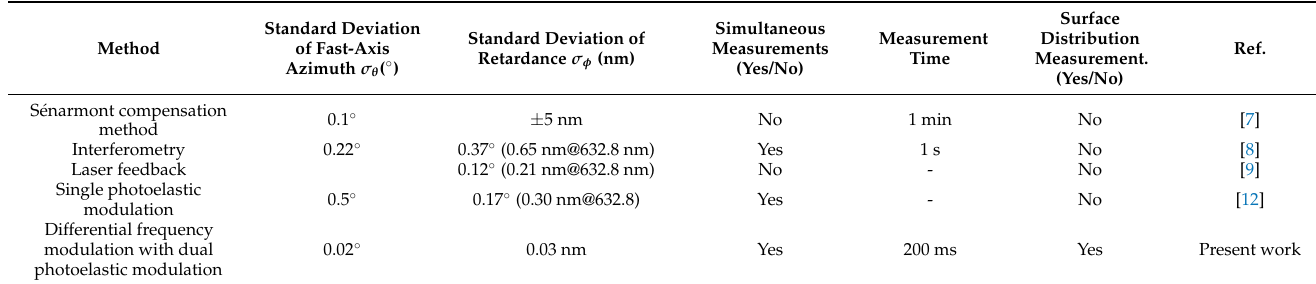
Table 3. Comparison with reported waveplate measurement